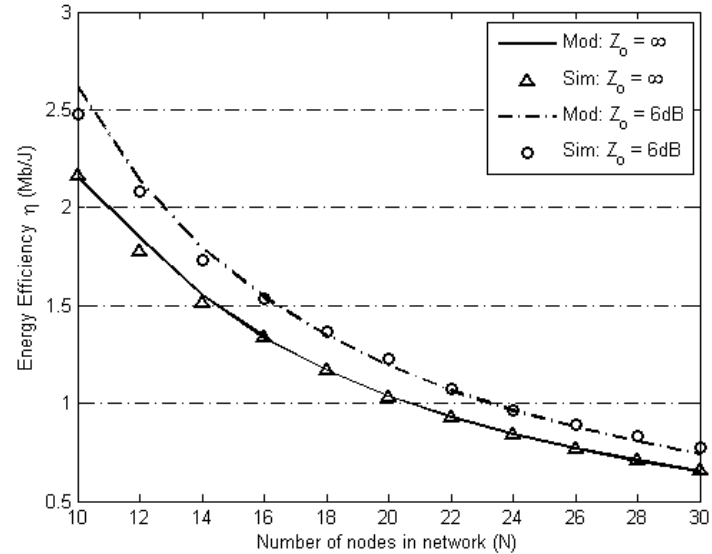
Figure 6. Energy efficiency in the presence and absence of capture effect with varying number of nodes in